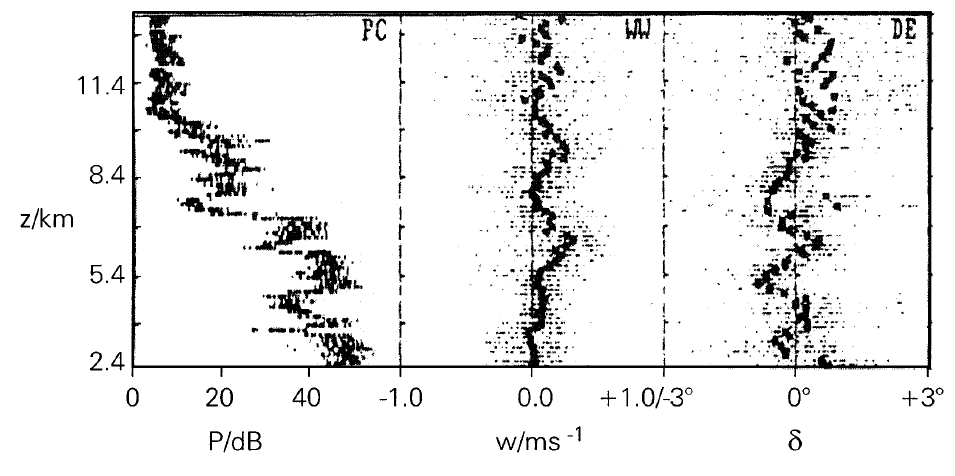
Fig. 4. Height profiles of the dis- tributions of normalized power P , radial velocity w in vertical beam and eastward component of the angle of arrival or zenith angle d , measured with the Chung-Li VHF radar on 19 December 1988, 1711–1714 UT. Individual data were taken every 6 s (after Ro¨ ttger et al ., 1990, Copyright American